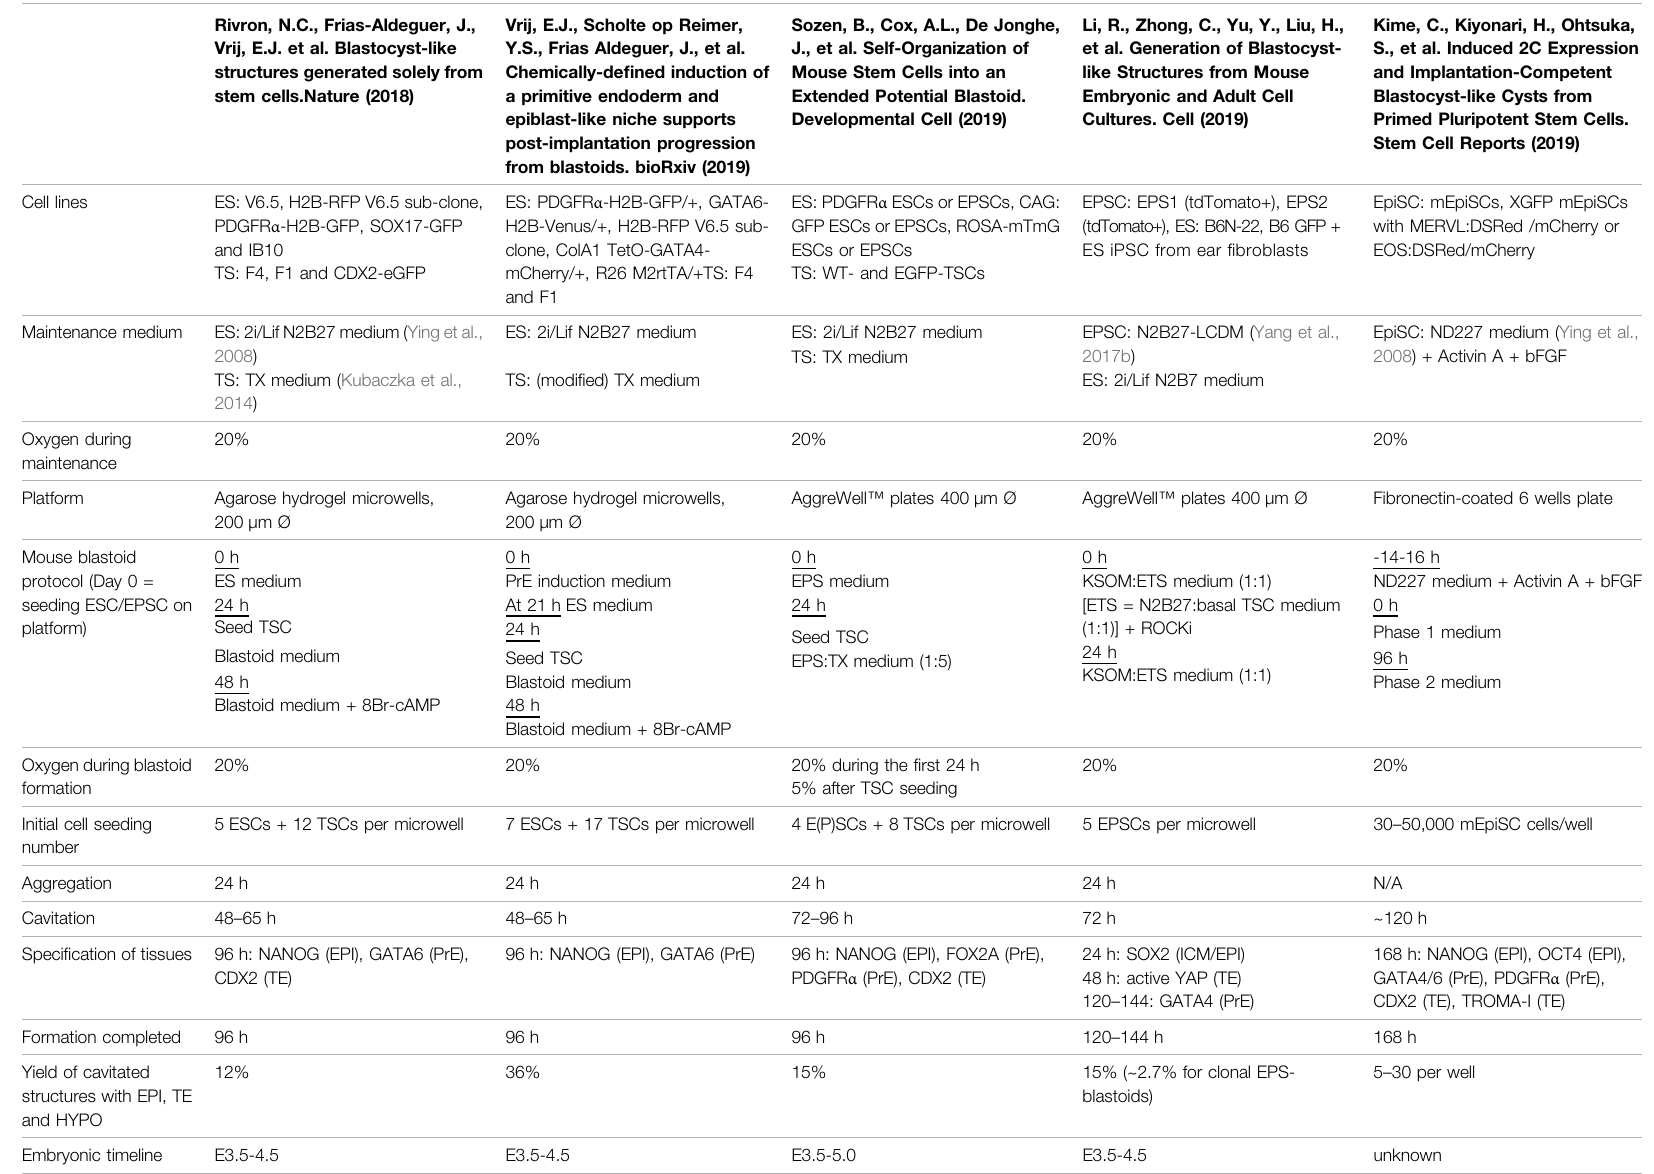
TABLE 1 | Overview of mouse blastoid protocols, summarizing culture conditions, experimental time lines, blastocyst marker expression, characterization experiments performed, post-implantation progression and limitations of the individual